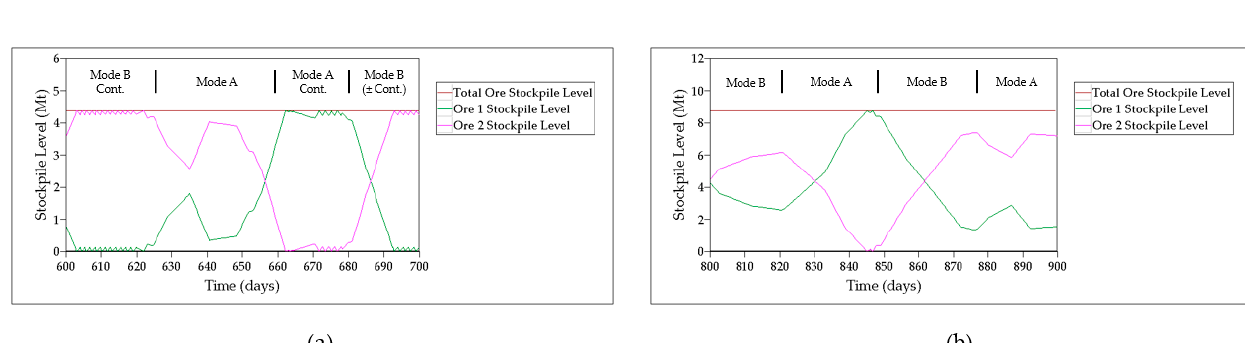
Figure 9. Simulated operational dynamics of Canadian oil sands data in response to geological uncertainty, configured with a critical ore 2 level of 2.916 Mt (deterministic value) and total stockpile target levels of ( a ) 4.374 Mt under Scenario 1; ( b ) 8.748 Mt under Scenario 3. Contingency modes are depicted by the fine jagged saw-tooth pattern and result from short contingency segments of 1 day; note the abundance of these ore shortages in ( a ) compared to ( b